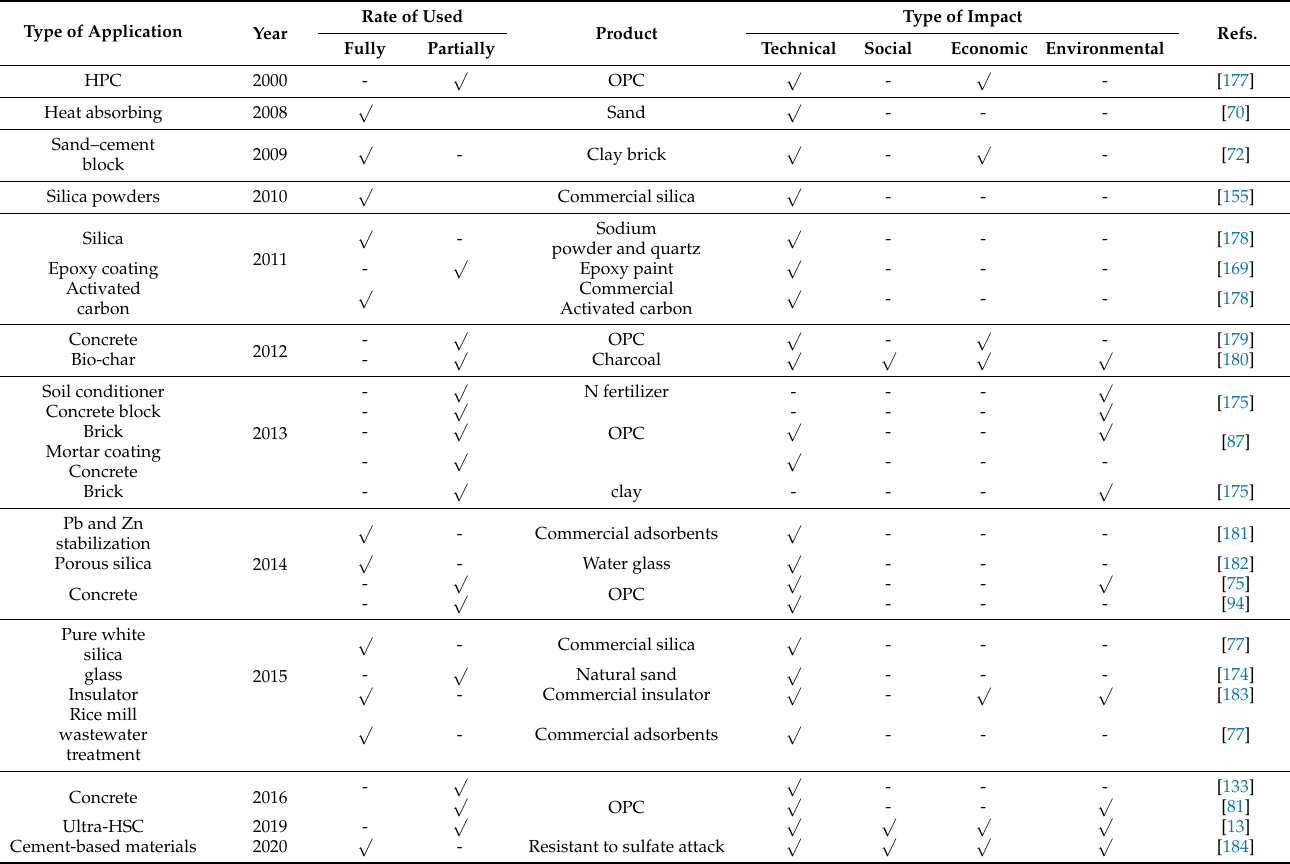
Table 10. Applications of RHA towards sustainability